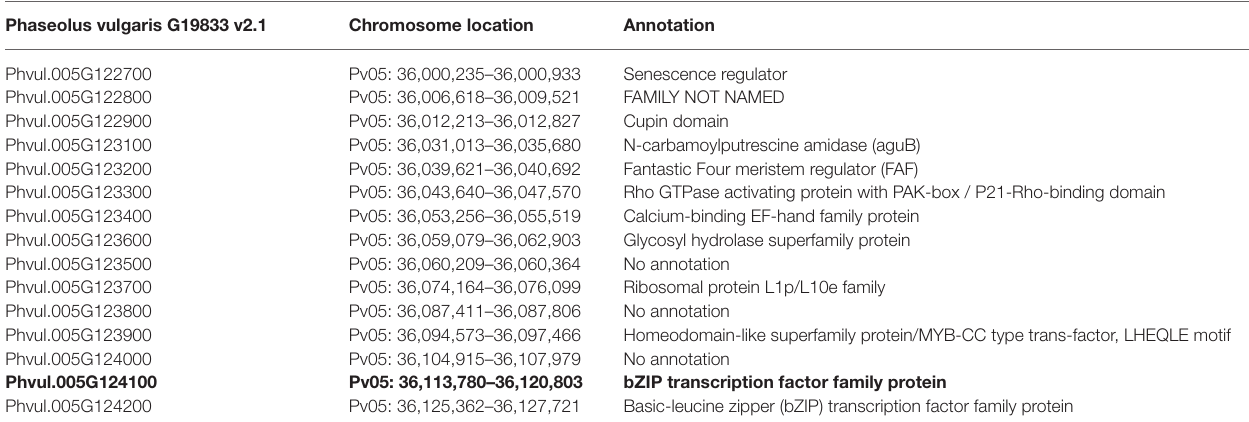
TABLE 4 | Candidate gene (bold type) for the bc-u d gene region. Phaseolus vulgaris G19833